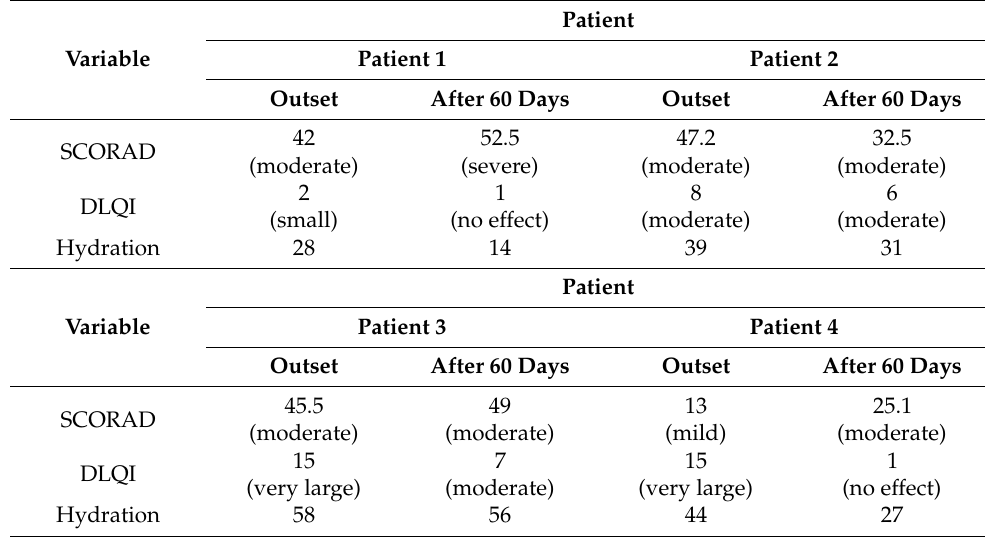
Table 6. SCORAD, DLQI, and skin hydration of each patient treated with CBlank